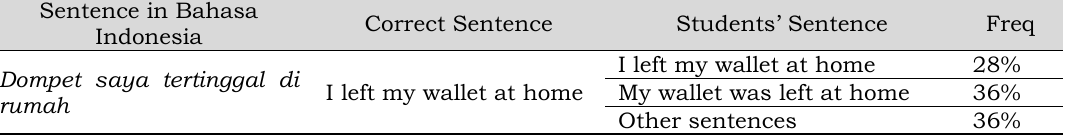
Table 1. The frequency of passive voice interference in the first sentence